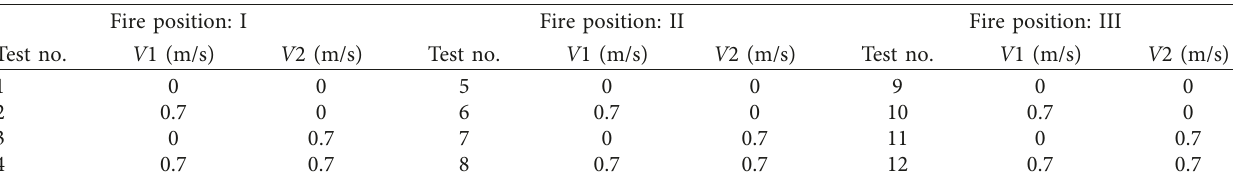
Figure 5: Measurement system: (a) layout and (b) diagram. Table 1: Fire model test